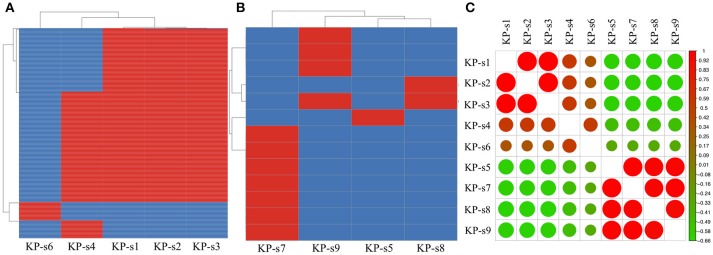
(A) SNP analysis in isolate KP-s1, KP-s2, KP-s3, KP-4, and KP-s5. One SNP was found within Clade 1. (B) SNP analysis in Clade 2 (isolate KP-s5, KP-s7, KP-s8, and KP-s9). A total of 13 SNPs existed within Clade 2. (C) Correlation heatmap of CP-Kp outbreak isolates.